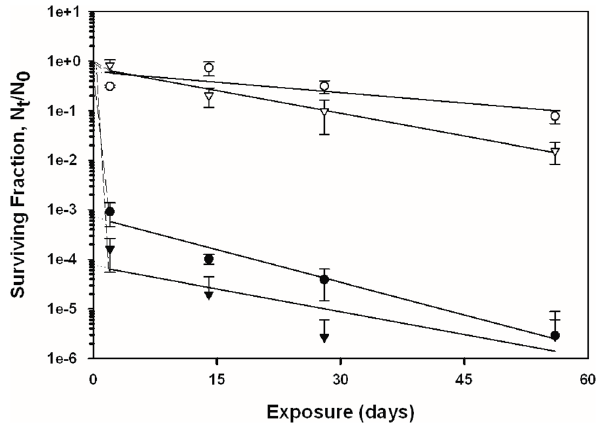
Fig 2. Inactivation curves of B . subtilis and B . anthracis spores on glass. Circles represent B . subtilis , triangles represent B . anthracis , shaded symbols represent coupons exposed to UV, and non-shaded symbols represent the coupons that were not exposed to UV. The data points and error bars are the averages and standard deviations of results from five replicate coupons. The surviving fraction of spores after each experiment was calculated by N t /N 0 , where the viable spore titer at any given time point ( N t ) was divided by the initial spore titer ( N 0 ). Dashed and solid lines represent the initial (first phase) and final (second phase) slopes of the curve,